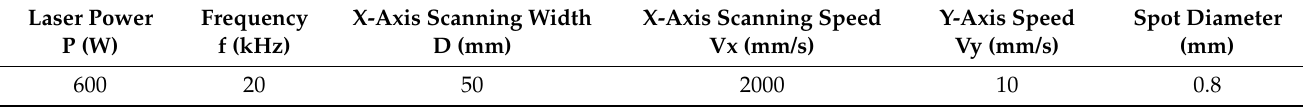
Table 2. Technological parameters of laser cleaning